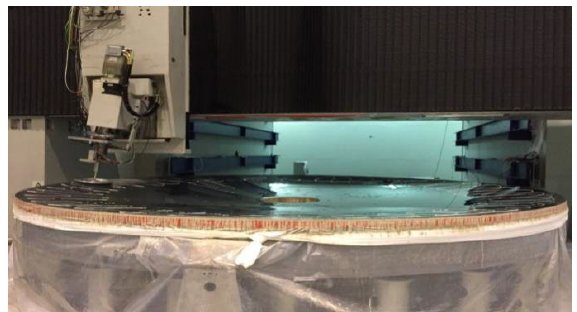
Fig. 18 300-mm diameter RC lap on 4-m-diameter RB-SiC mirror at